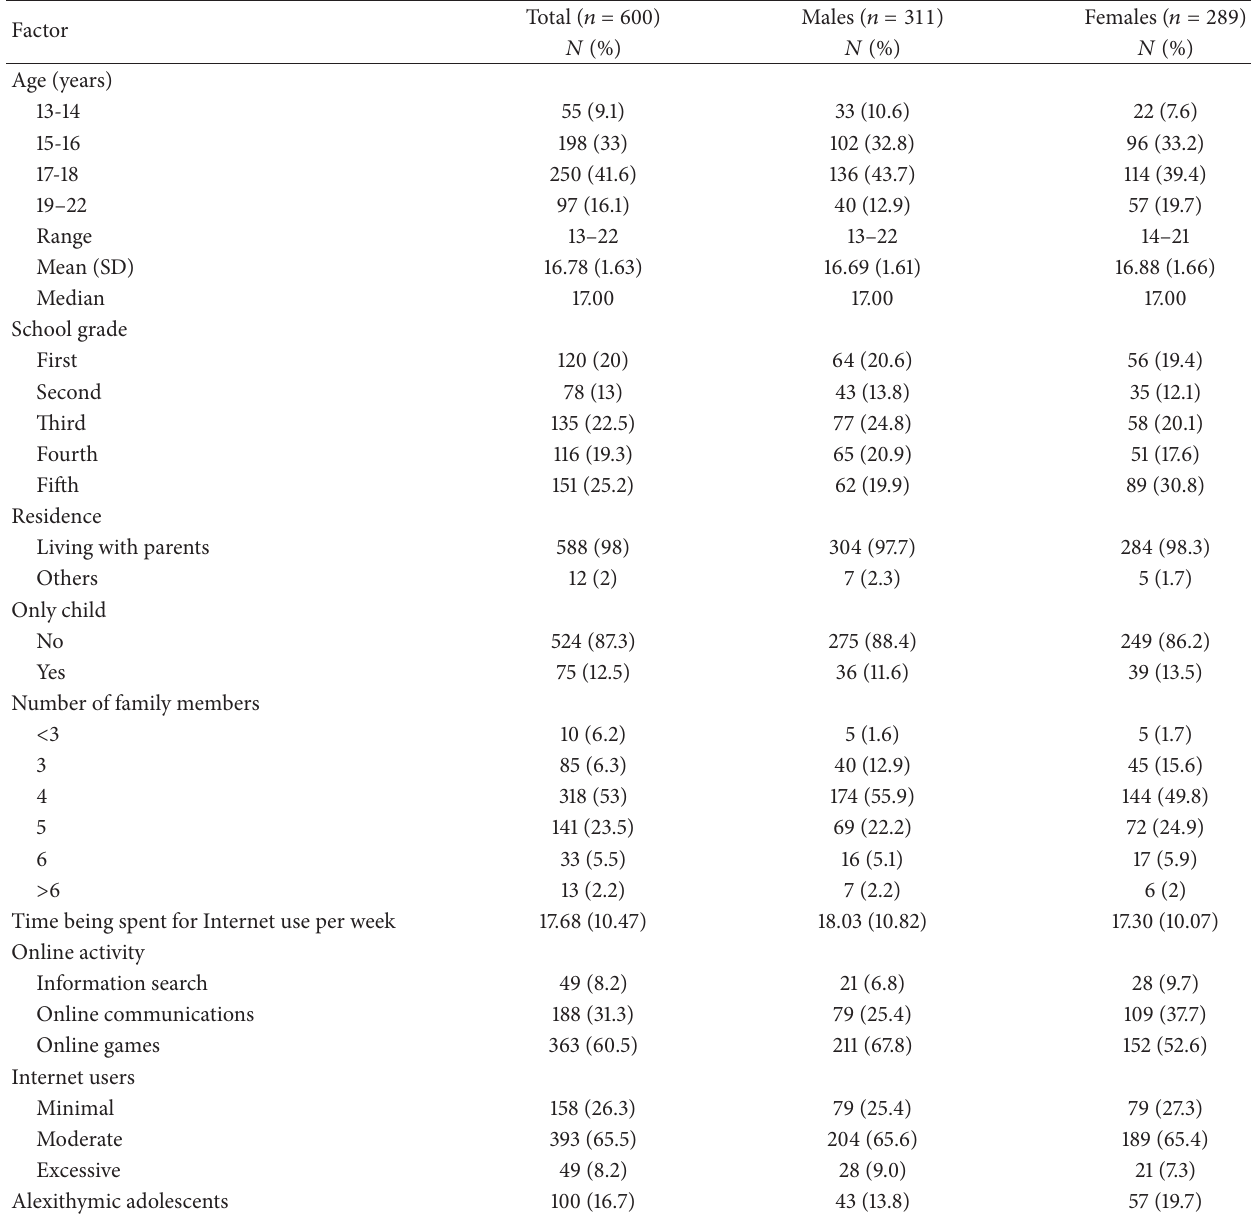
Table 1: Participants sociodemographics by gender.